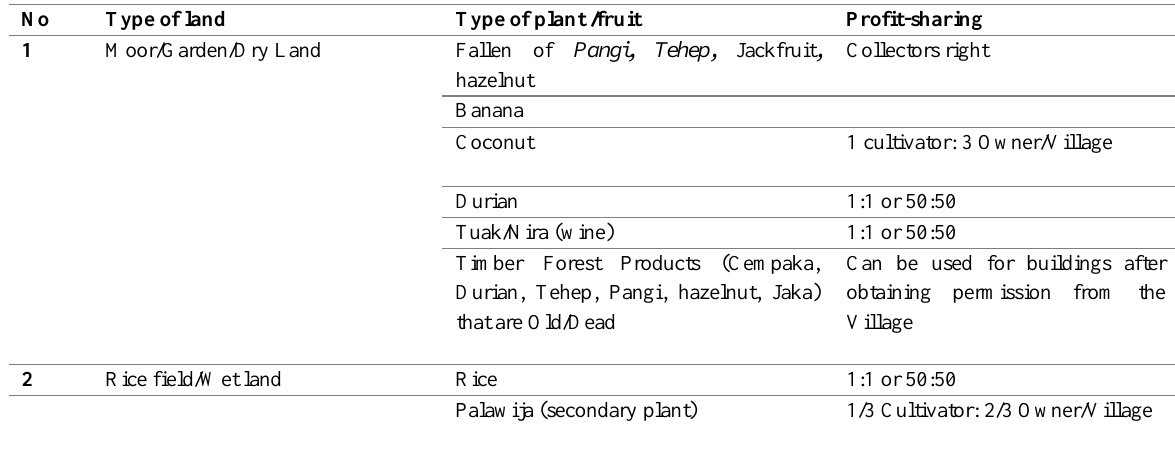
Table 1: Type of land, plant/fruit and profit